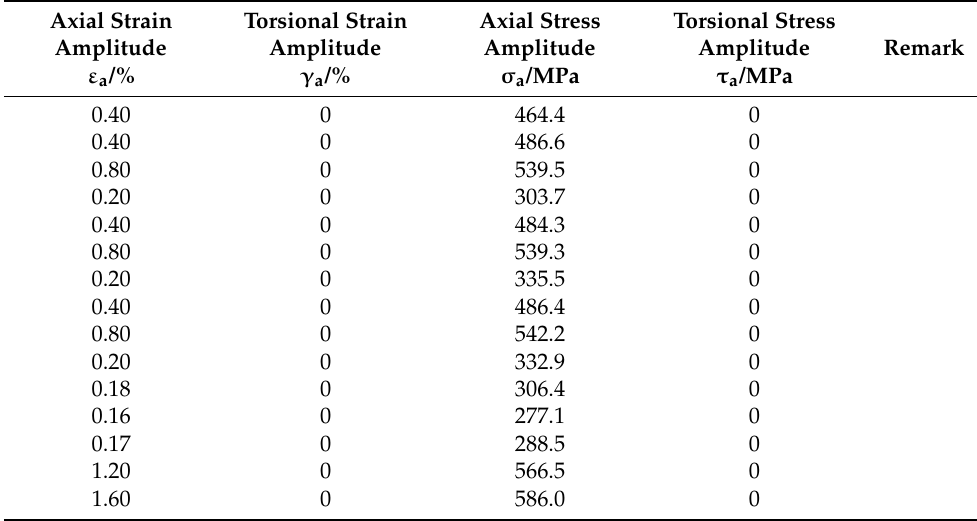
Table A6. Test results for pure axial tests.